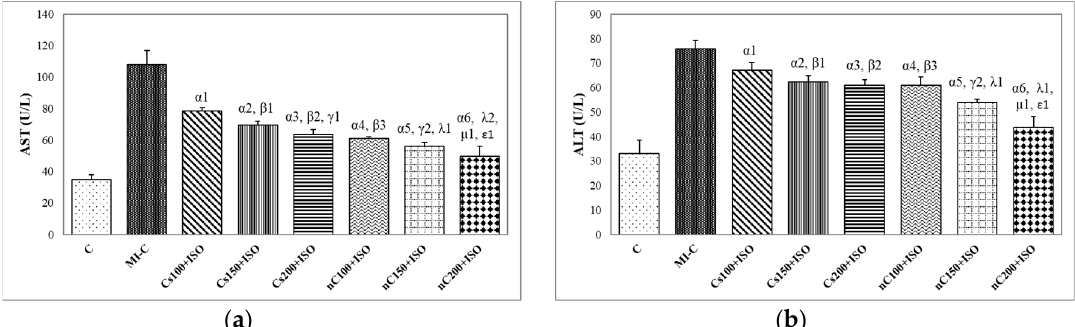
Figure 5. Serum levels of: ( a ) aspartate transaminase (AST) and ( b ) alanine transaminase (ALT) by groups. C = control; MI-C = isoproterenol without any pre-treatment ; Cs = curcumin solution, in doses of 100 mg/kg bw (Cs100), 150 mg/kg bw (Cs150), and 200 mg/kg bw (Cs200); nC = curcumin nanoparticle solution, in doses of 100 mg/kg bw (nC100), 150 mg/kg bw (nC150), and 200 mg/kg bw (nC200). The letter-number codes correspond to the p-values < 0.05: α as compared with MI-C, β as compared with CS100+ISO, γ as compared with CS150+ISO, λ as compared with nC100+ISO, μ as compared with nC150+ISO, ε as compared with Cs200+ISO.